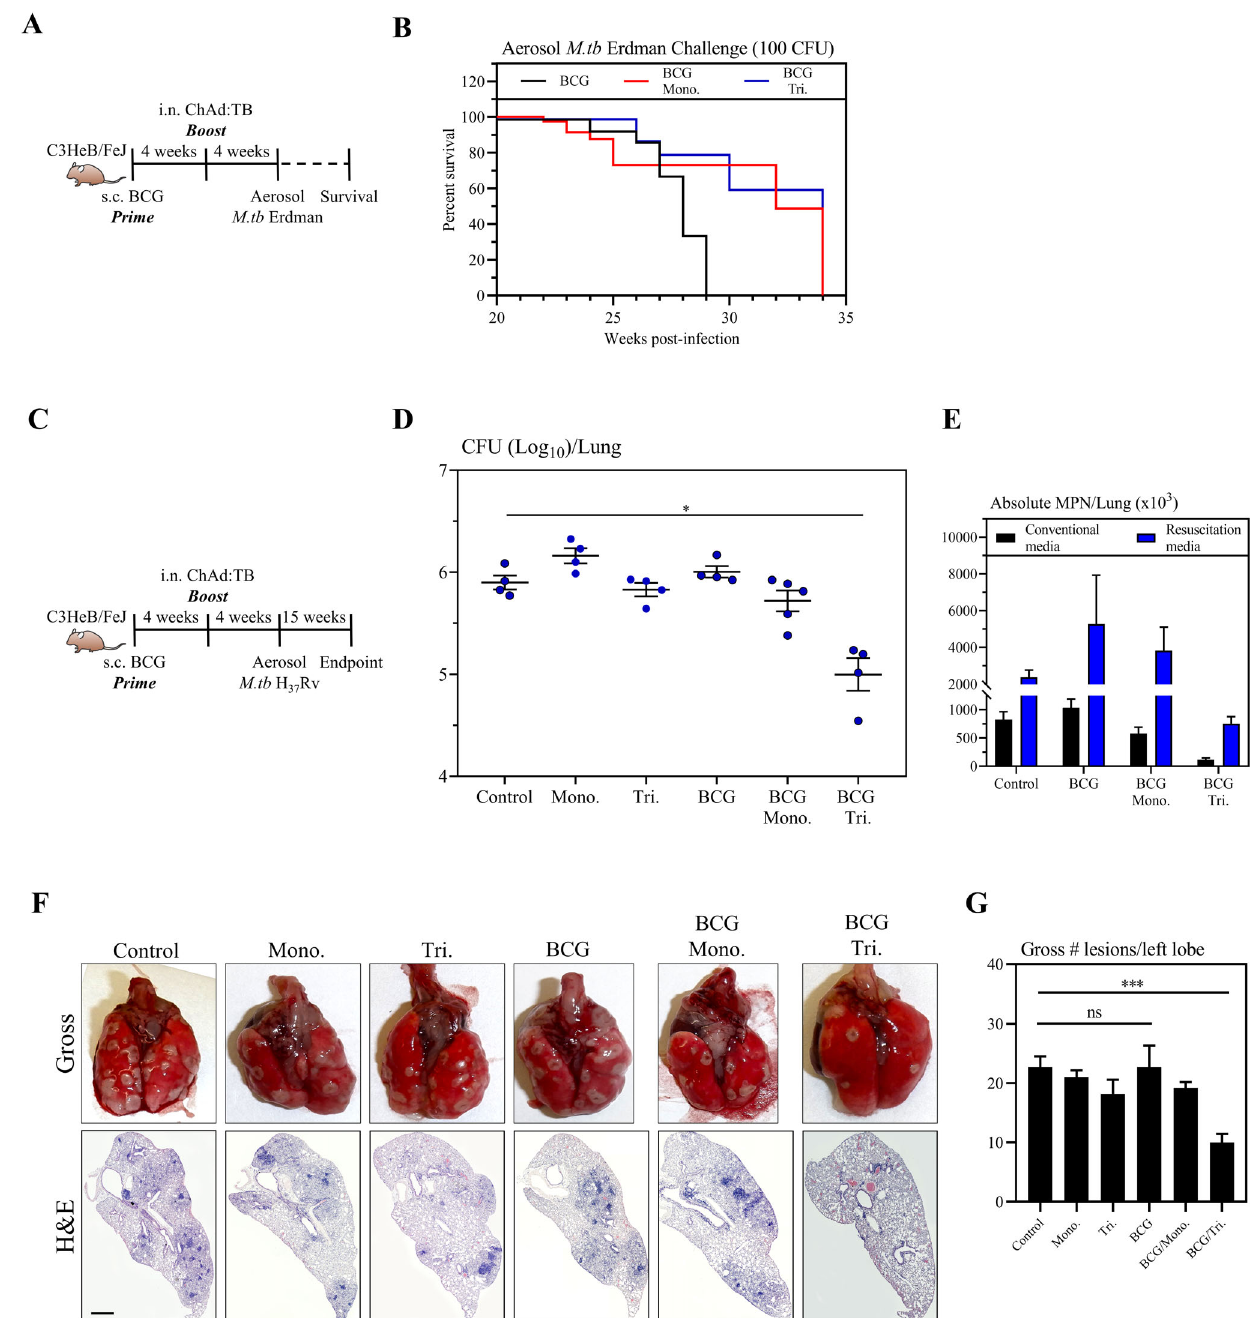
Fig. 5 Protective ef fi cacy of a multivalent ChAd:TB vaccine against M.tb in the C3HeB/FeJ model. A Experimental schema, pertaining to panel B . B Survival curve following aerosol challenge with M.tb (Erdman). C Experimental schema, pertaining to panels D – G . D Lung mycobacterial burden (Log 10 colony-forming unit (CFU)) 15 weeks post- M.tb challenge via aerosol. E Most Probable Number (MPN) estimates to assess actively replicating bacilli (conventional media, black bars) and persisters (resuscitation media, blue bars). F Top: Representative gross lung pathological images 15 weeks post- M.tb challenge. Bottom: Representative lung histopathological images of H&E staining 15 weeks post- M.tb challenge. Scale bars represent 200 µm. G Bar graph depicting total number of gross lesions on the left lungs. Data presented in ( D , E , G ) represent mean ± SEM of n = 4 – 5 mice/group. Data are representative of one independent experiment. Statistical analysis for ( D , G ) was performed using a nonparametric Kruskal – Wallis with Dunn ’ s multiple comparison test. * P = 0.05, *** P = boosted animals tended to succumb to infection slightly later than boost were aerosol challenged with virulent M.tb (Erdman) (Fig. those boosted with its monovalent counterpart. 5A). As a control, some mice were BCG-primed for 8 weeks and We next examined the capacity of our multivalent ChAd:TB infected. Improved survival was observed in boosted animals vaccine in controlling pulmonary bacterial burden and limiting (BCG/Mono. and BCG/Tri.) over the control animals (BCG) (Fig. 5B). pathology in this stringent model. Naive mice or 4-week s.c. BCG- Although survival rates did not differ signi fi cantly between mice primed mice were i.n. immunized with either Tri:ChAd:TB or its boosted with either Mono:ChAd:TB and Tri:ChAd:TB, Tri:ChAd:TB-